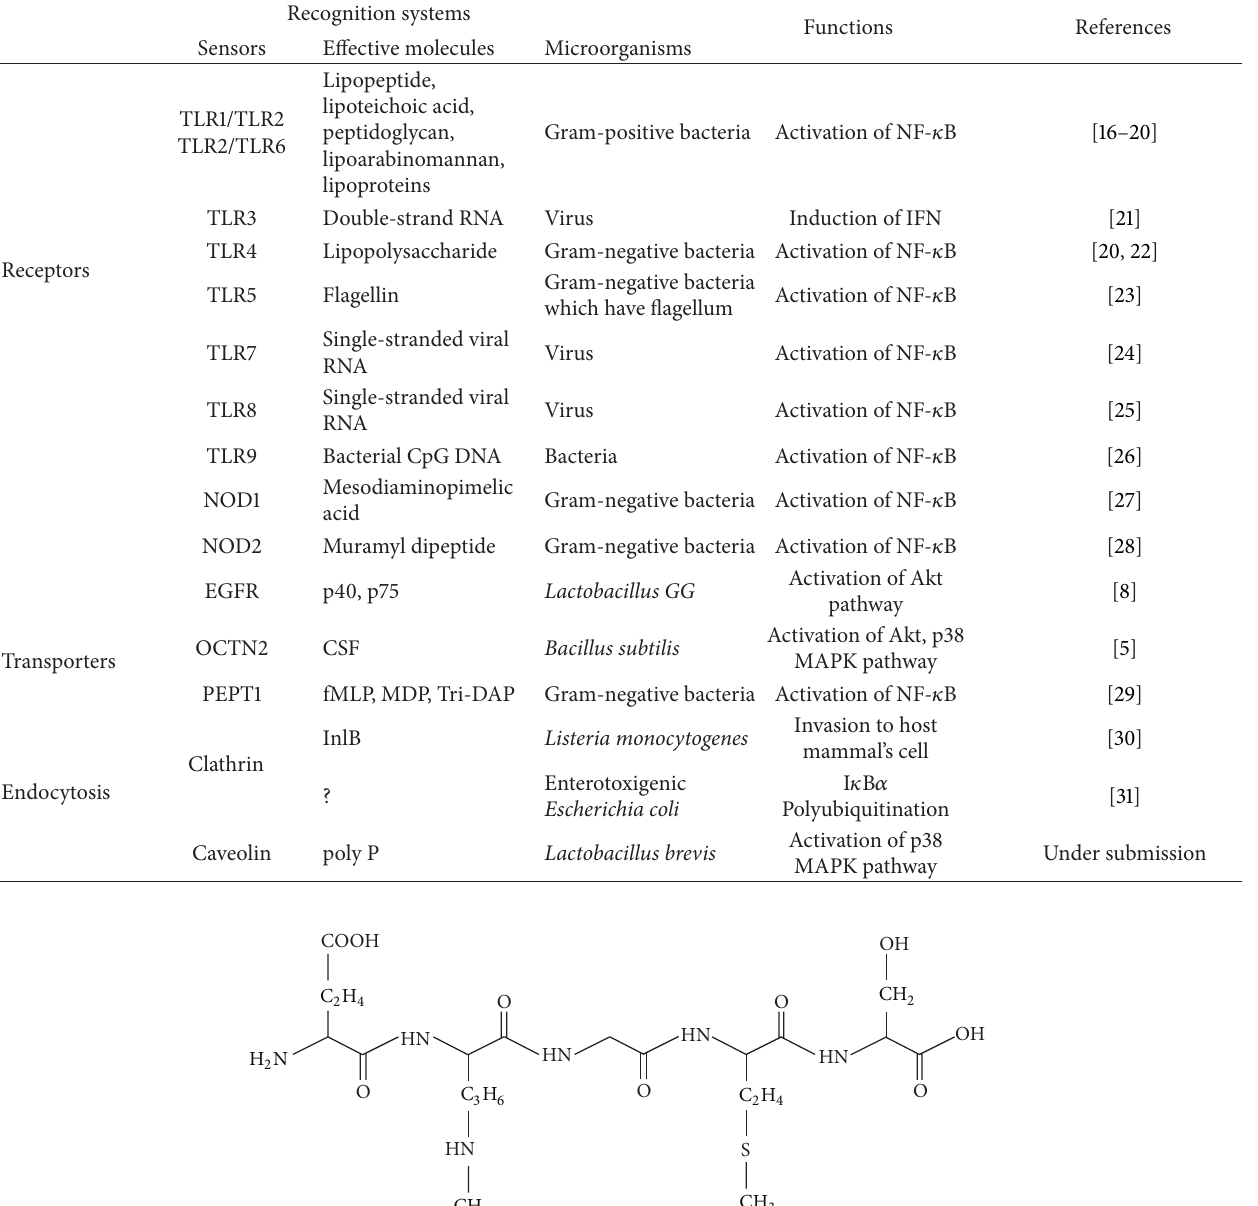
Table 1: Recognition systems for microorganisms.